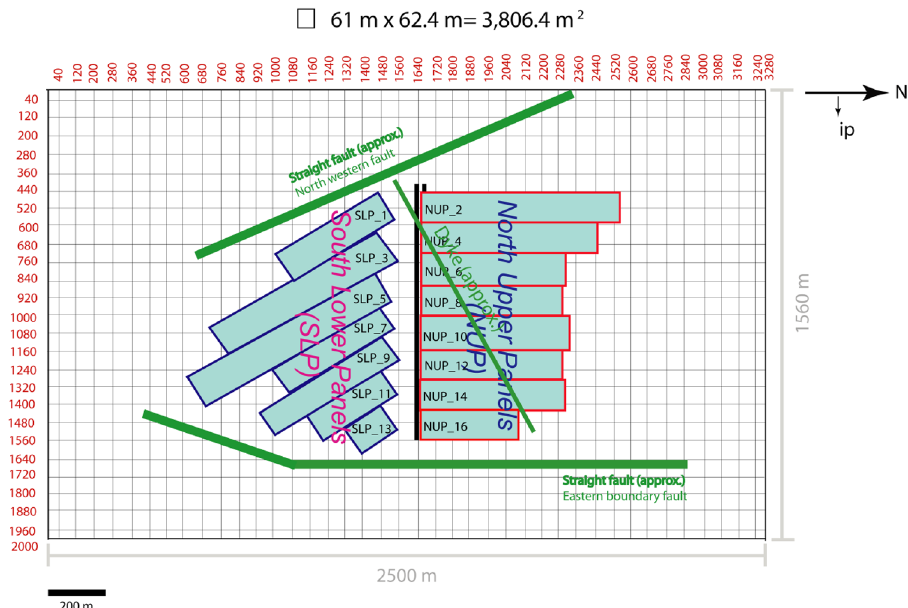
Figure 7. The mine model with mine panels and main